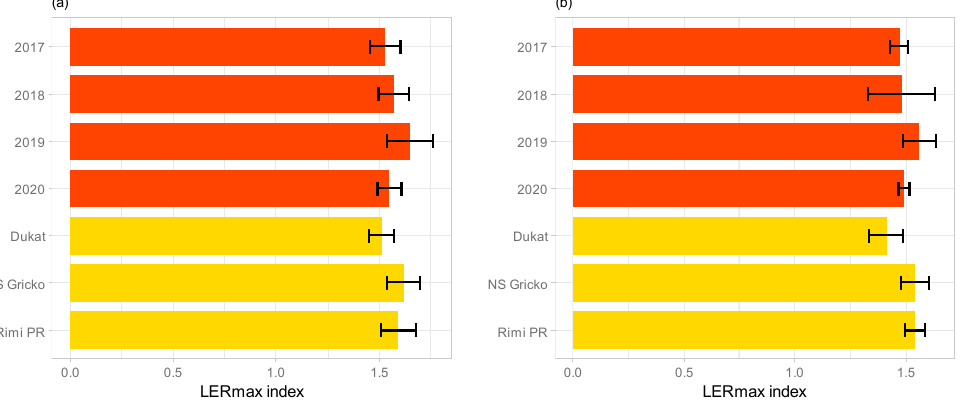
Figure 4. Adjusted land equivalent ratio (LER max ); ( a ) sunflower × red clover; ( b ) sunflower × alfalfa intercropping.